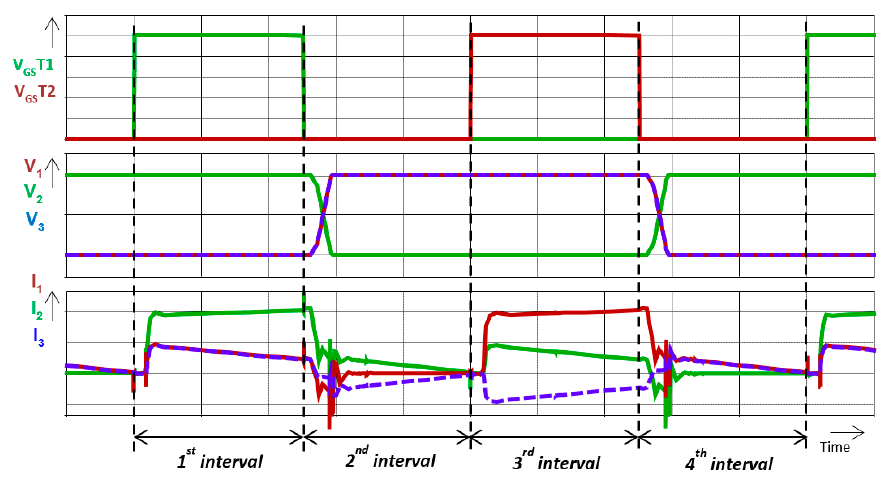
Figure 4. Driving impulses of transistors T 1 and T 2 .